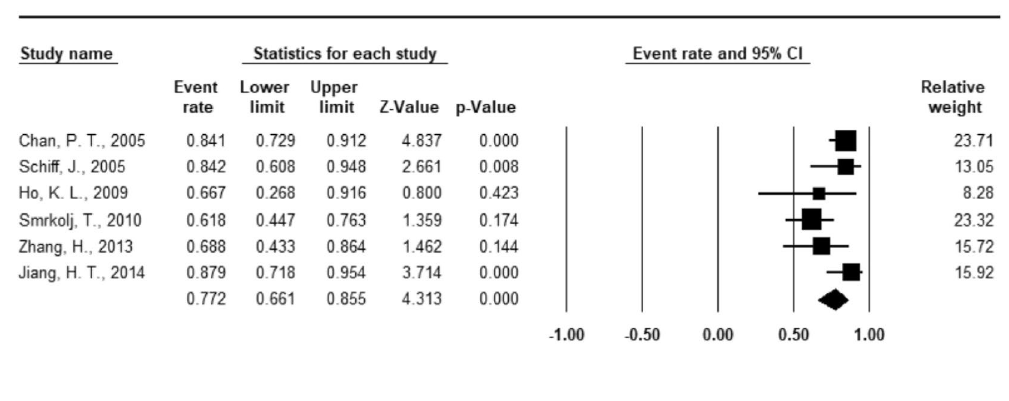
Figure 4. Forest plots of patency rate under 3-suture double-armed triangulation and 2-suture double-armed transverse IVE